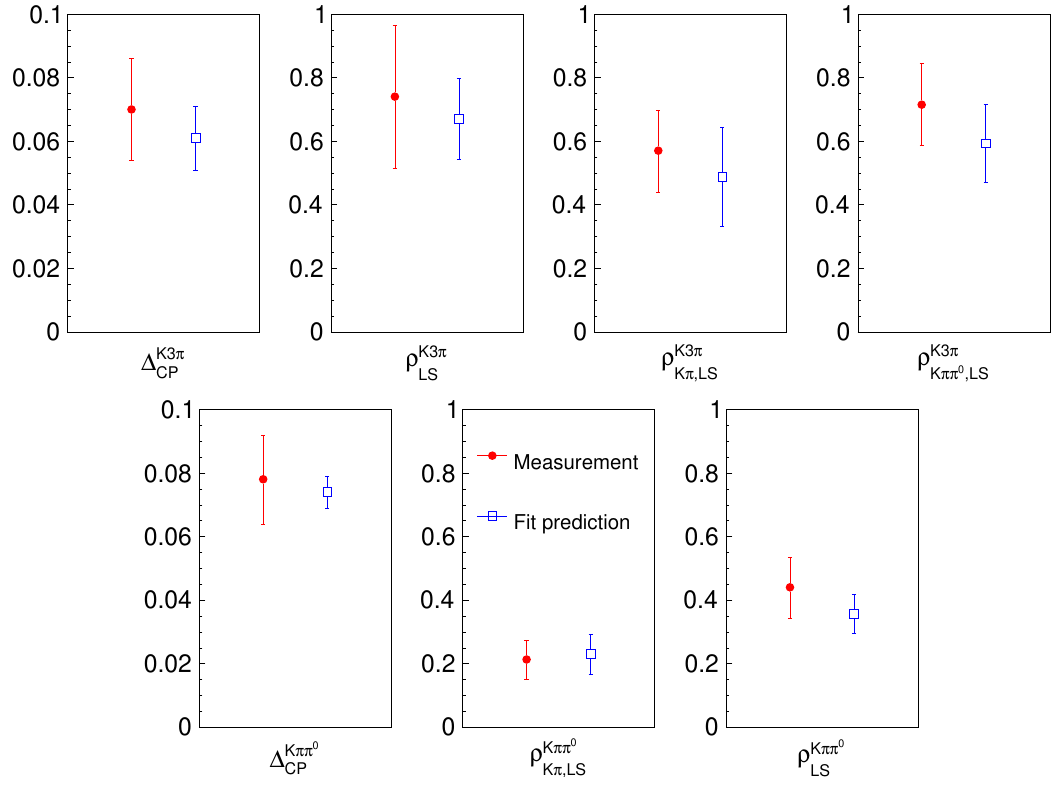
Figure 7 . Results for the CP -tagged and like-sign global observables. Also shown are the predic- tions from the fit to these observables and the K 0